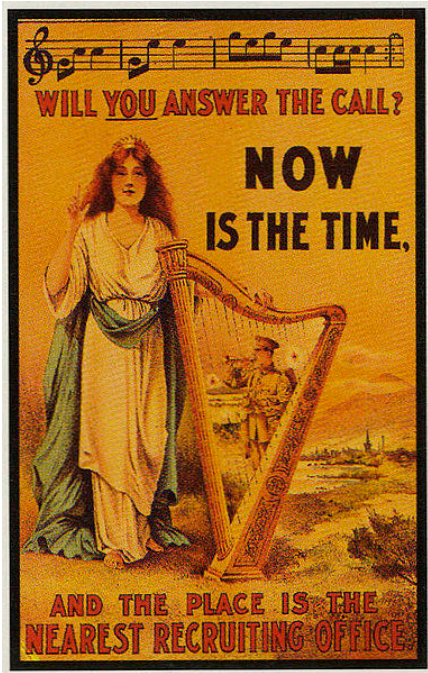
Figure 1. Irish First World War recruitment poster. This 1915 recruitment poster personifies Ireland as a woman with a harp. In doing so, it draws on Irish nationalist iconography (Irish WW1 Recruitment Poster 2012). Used under the Creative Commons